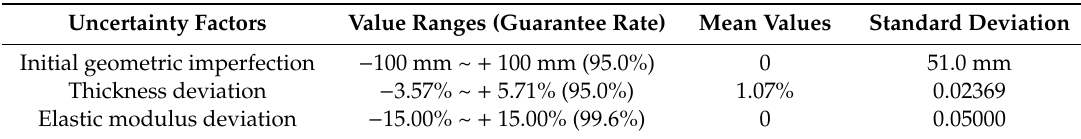
Table 1. Stochastic models of